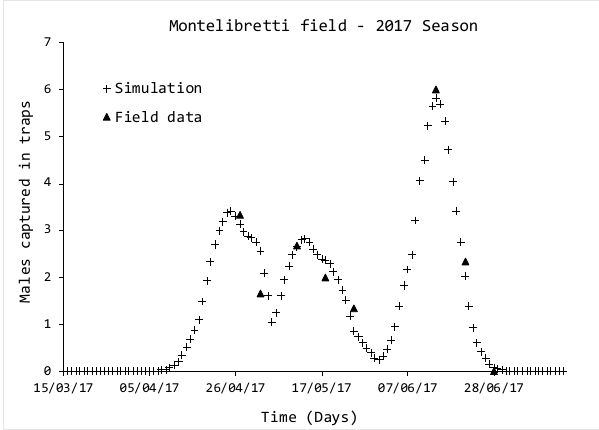
Figure 2. Comparison between simulated and monitored D. suzukii populations, in 2017. Triangle indicators represent data from traps, while crosses indicate simulations.